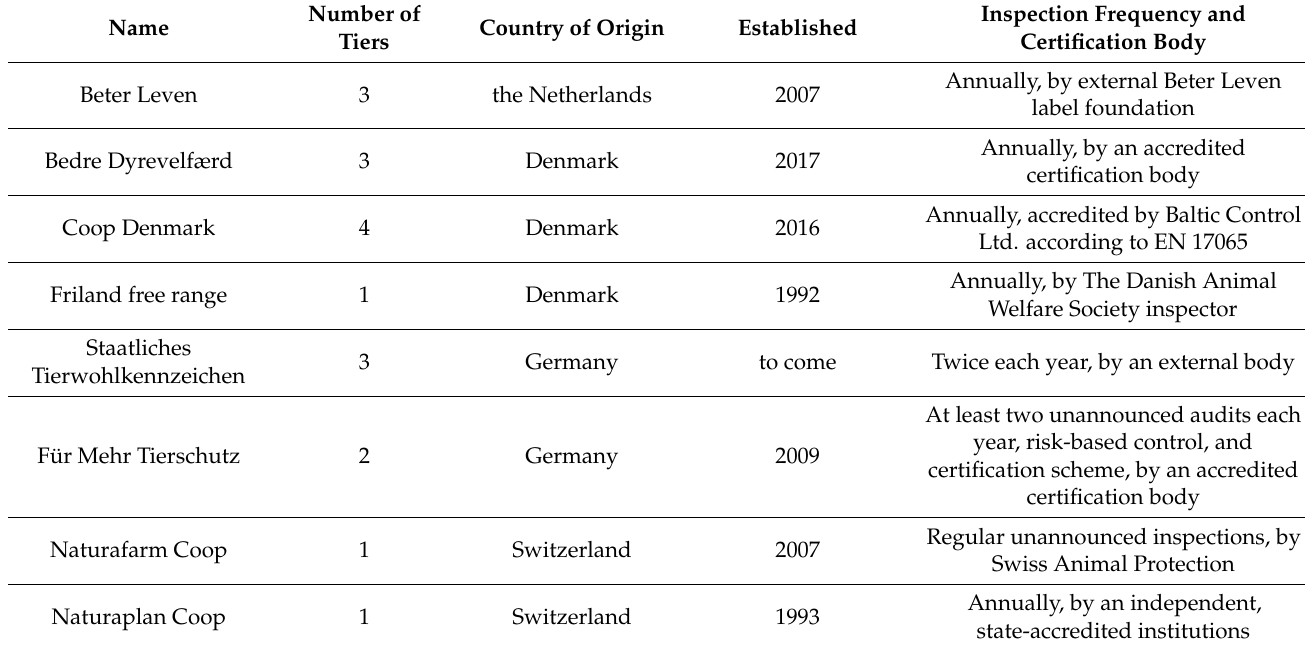
Table 1. Number of tiers, country of origin, establishment year, inspection frequency, and certification body of labels reviewed in the